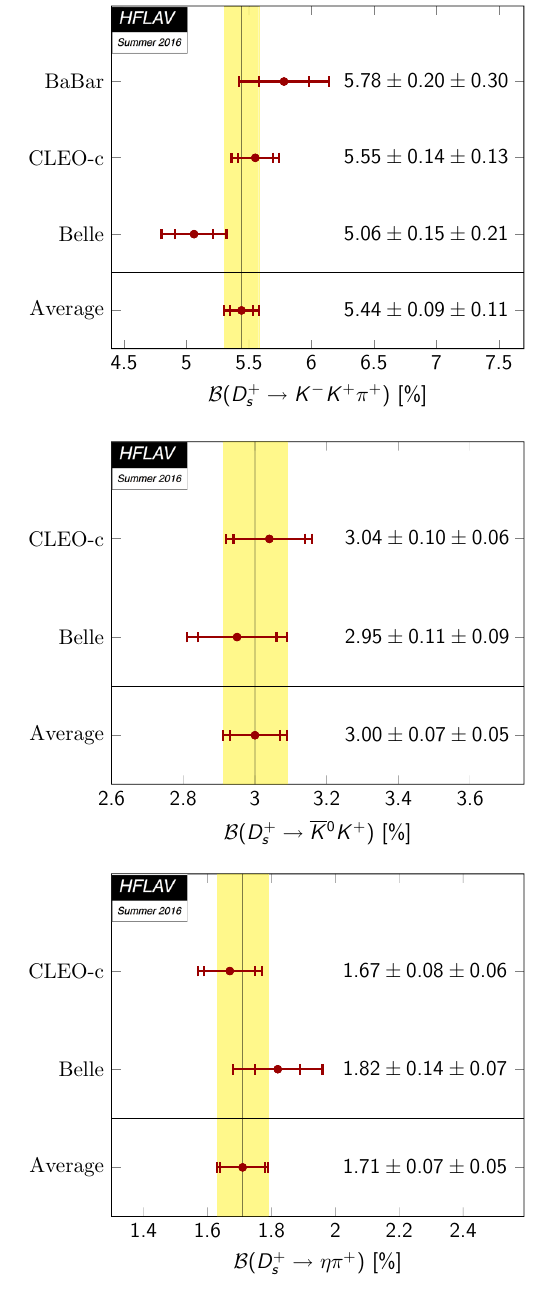
Fig. 208 WA values for B ( D + s → K − K + π + ) ( top ), B ( D + s → K 0 π + ) ( middle ), B ( D + s → ηπ + ) ( bottom ). For each point, the first error listed is the statistical and the second error is the systematic error (cid:5) E , the difference between the candidate D 0 energy and the beam energy (e.g., E K + E π − E beam for D 0 → K − π +